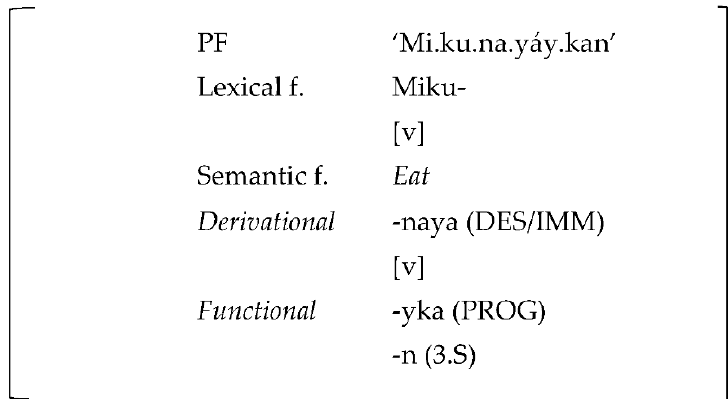
15 Figure 3. Alignment for mikunayanmi in Lamas Kechwa. 15